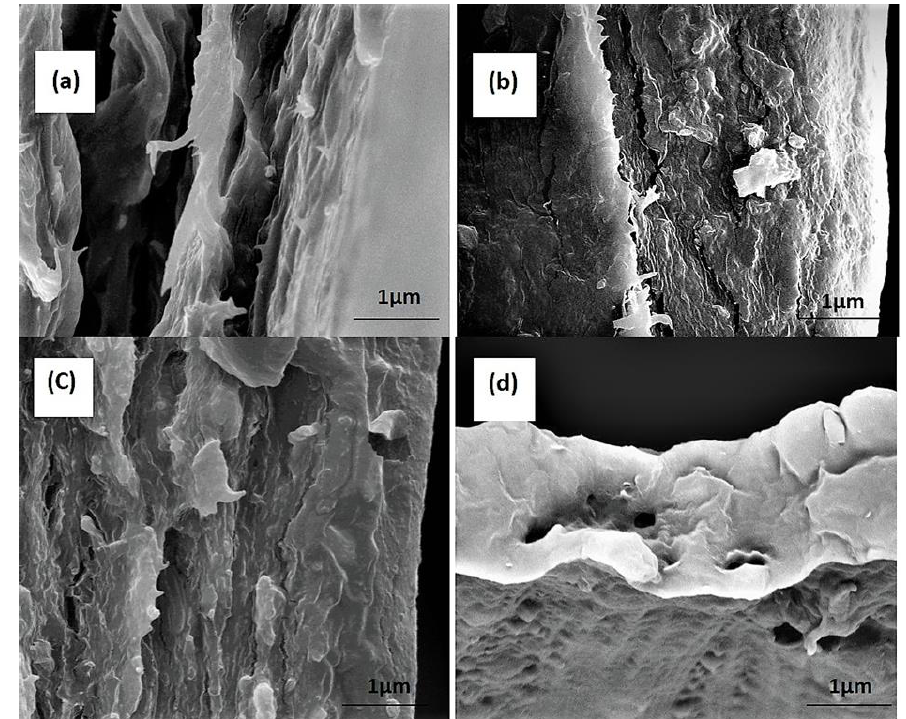
Figure 4. Fractured morphologies of ( a ) the control film and composite film with ( b ) 0.1% C–CaCO 3 ; ( c ) 0.15% MB–CaCO 3 ; and ( d ) conventional mulch film.